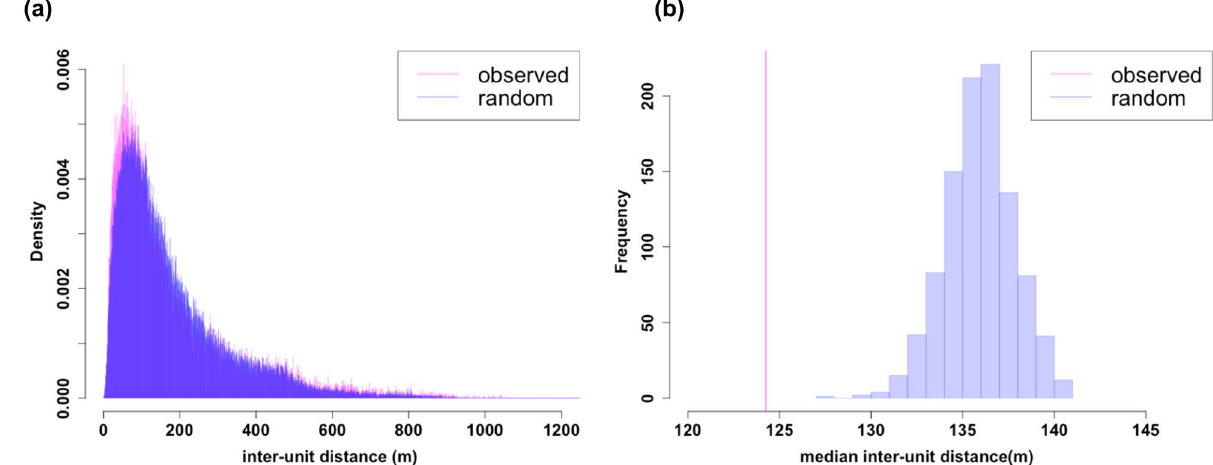
Figure 4. Histogram of ( a ) interunit distances and ( b ) the maximum interunit distances at each observation time and Zone. The graphs were created using the statistical software R 49 .